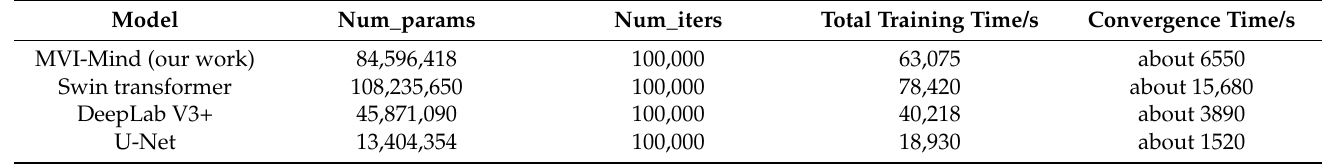
Table 4. Performance comparisons of various deep automatic segmentation models.